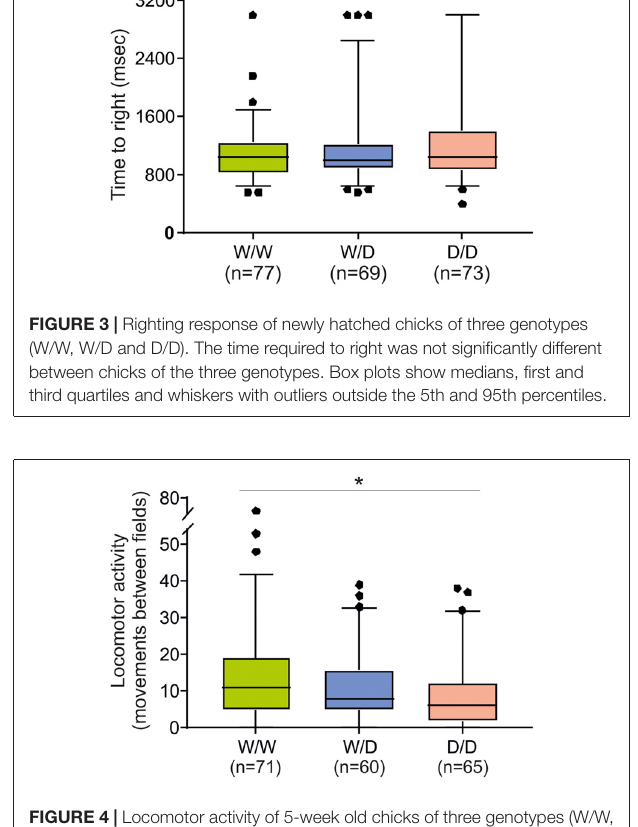
FIGURE 4 | Locomotor activity of 5-week old chicks of three genotypes (W/W, W/D and D/D) in the open field test. The total number of movements between fields was different between W/W and D/D chicks ( P = 0.015). Box plots show medians, first and third quartiles and whiskers with outliers outside the 5th and 95th percentiles. ∗ P < 0.05.